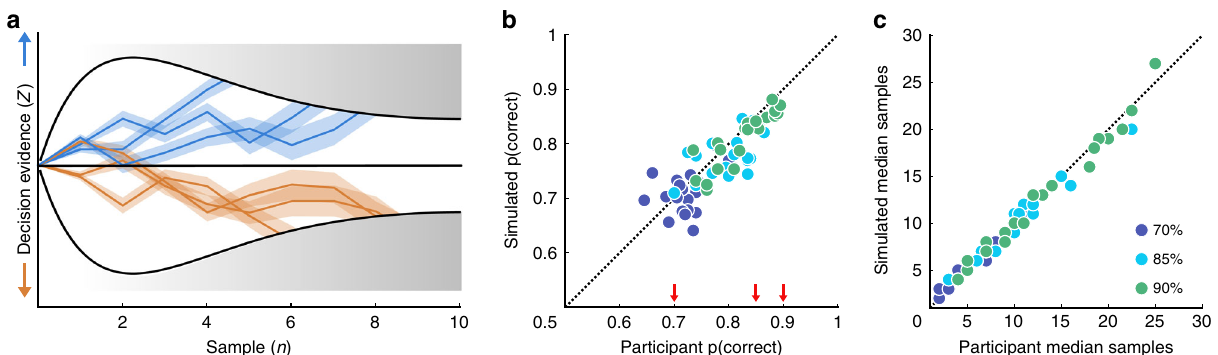
Fig. 2 Computational model and simulations. a On each trial, the observer sums the decision evidence ( z ) of each sample, n , which is the log-probability of the orientation, given the distribution ð ‘ n Þ , corrupted by additive i.i.d. Gaussian noise ( ε n , with standard deviation σ ), and weighted according to the observer ’ s leak ( v n , an exponential function of α ). Three example trials are shown from each distribution (blue and orange traces, with the shading representing the variability due to noise). Evidence accumulation stops once the evidence reaches the bound, in this case a collapsing bound de fi ned by Λ n , shown by the black curves. b Participant proportion correct against the simulated data based on the fi tted parameters of the computational model, for each participant in each condition of the Stopping task (70%, 85% and 90% correct in blue, cyan and green, respectively). The diagonal shows equality. Red arrows mark the performance targets. c The same as b for the median number of samples the observer chose to respond Fig. 2b, c. The relative placement of this bound, given the suboptimalities in their evidence accumulation, controlled how well observers were able to meet the target performance levels.